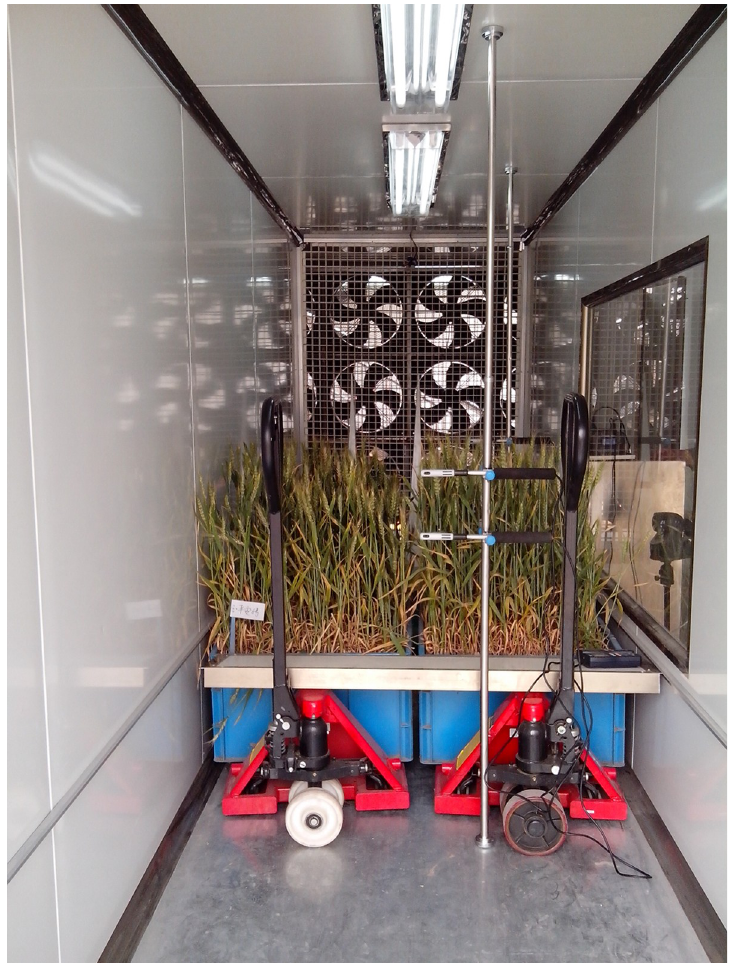
Fig 3. Wind tunnel simulation of lodging resistance in